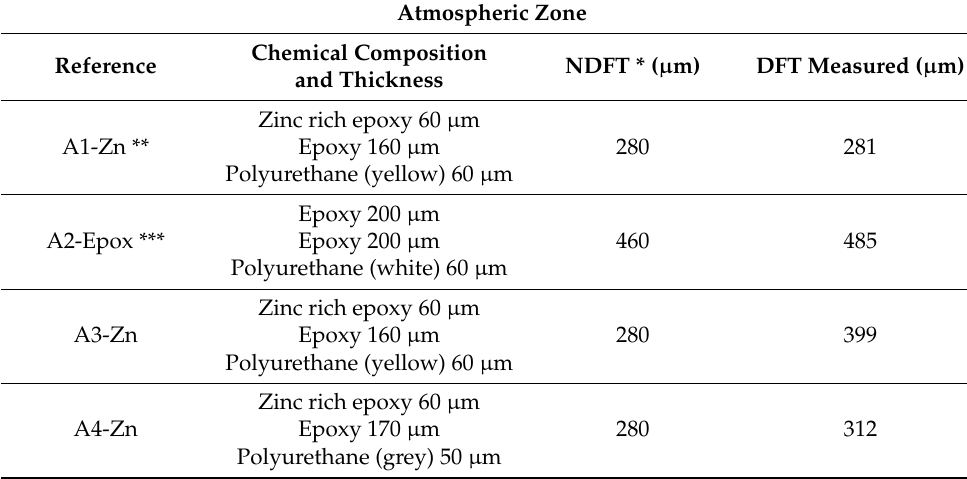
Table 4. Selected coating systems for the atmospheric zone.